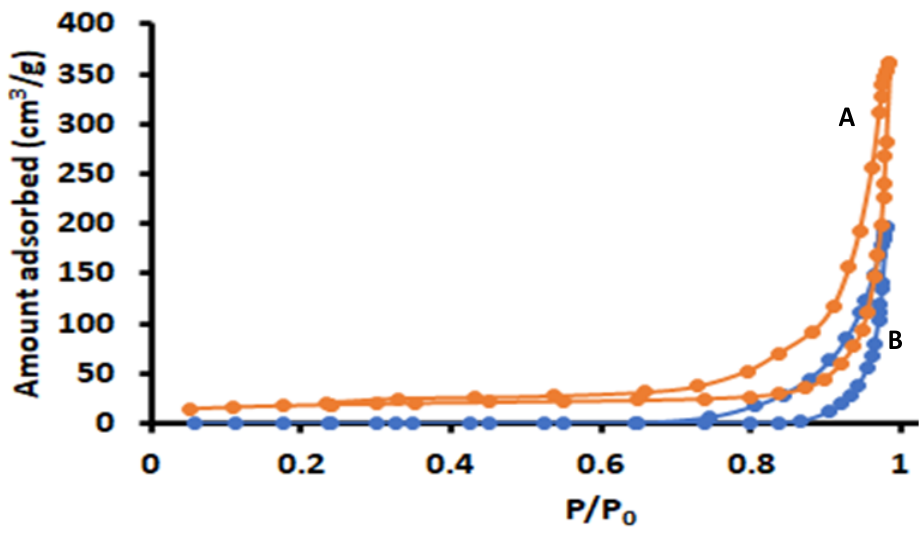
Figure 5. Nitrogen adsorption/desorption isotherms of ( A ) ZIF-8 and ( B ) Zn−Al−LDH@ZIF−8 .